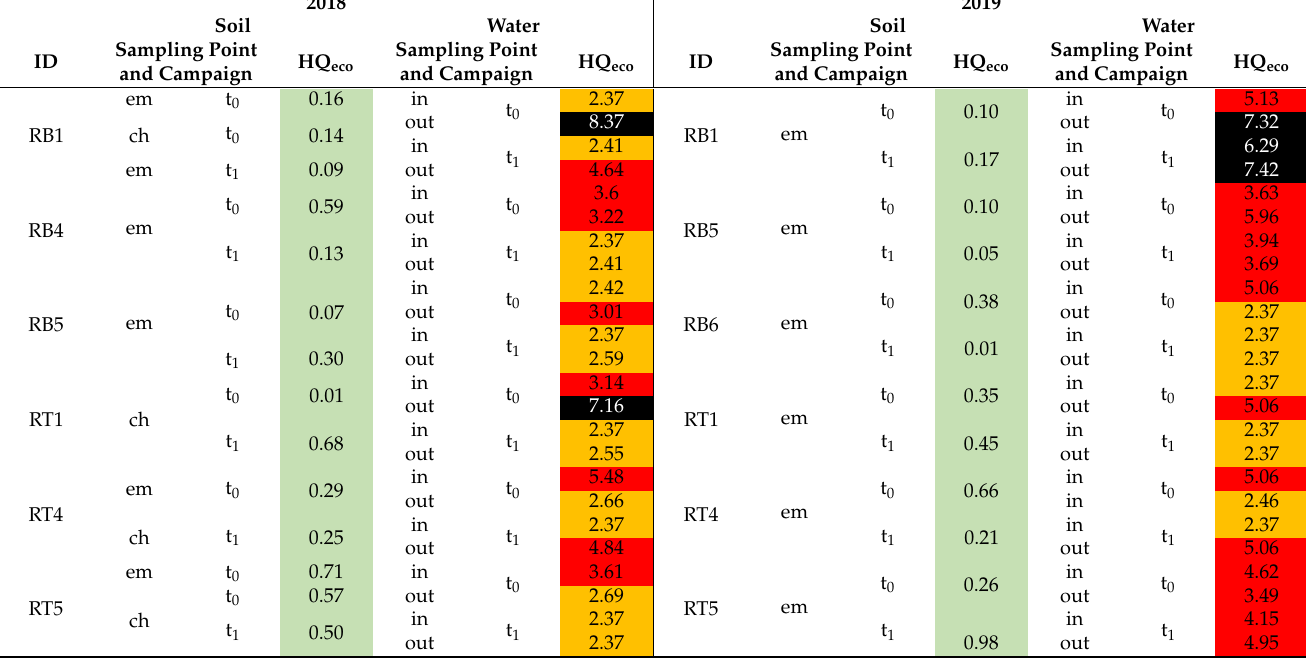
Table 7. Ecotoxicological hazard (HQ eco ) applied to paddy field soil samples. The index is referred to as a bioassay battery with 7 test species. Colors refer to the level of hazard as follows: green = absent; orange = moderate; red = major; black =